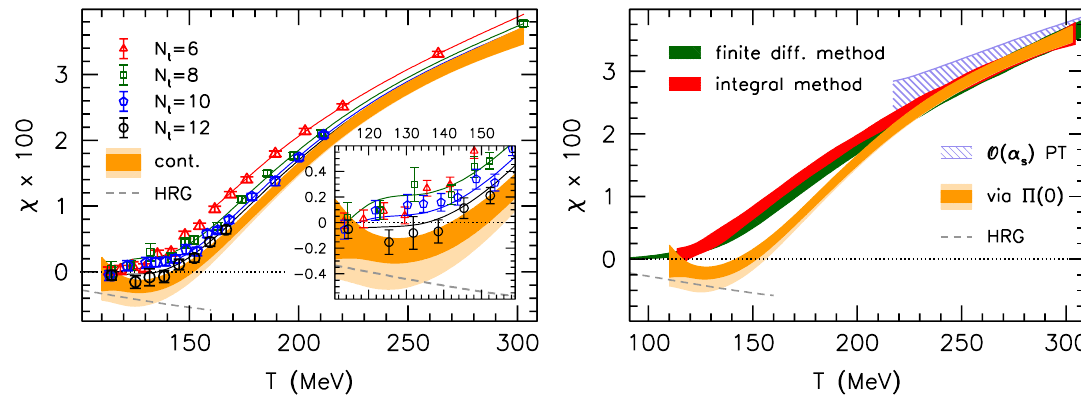
Figure 4 . Left panel: renormalized susceptibility at nonzero temperature. The symbols indicate di(cid:11)erent lattice spacings and the dark orange band the continuum limit. The light orange band represents an estimate of systematic errors of the continuum extrapolation. The dashed gray line is the HRG model prediction [28]. The inset zooms into the low-temperature region to highlight the diamagnetic response there. Right panel: our results for (cid:31) (orange, labeled \via (cid:5)(0)") are compared to the results of ref. [47] (green) and those of ref. [28] (red) as well as to the HRG model prediction (dashed gray line) and to perturbation theory [28] (dashed light blue band), see eqs. (4.3) and